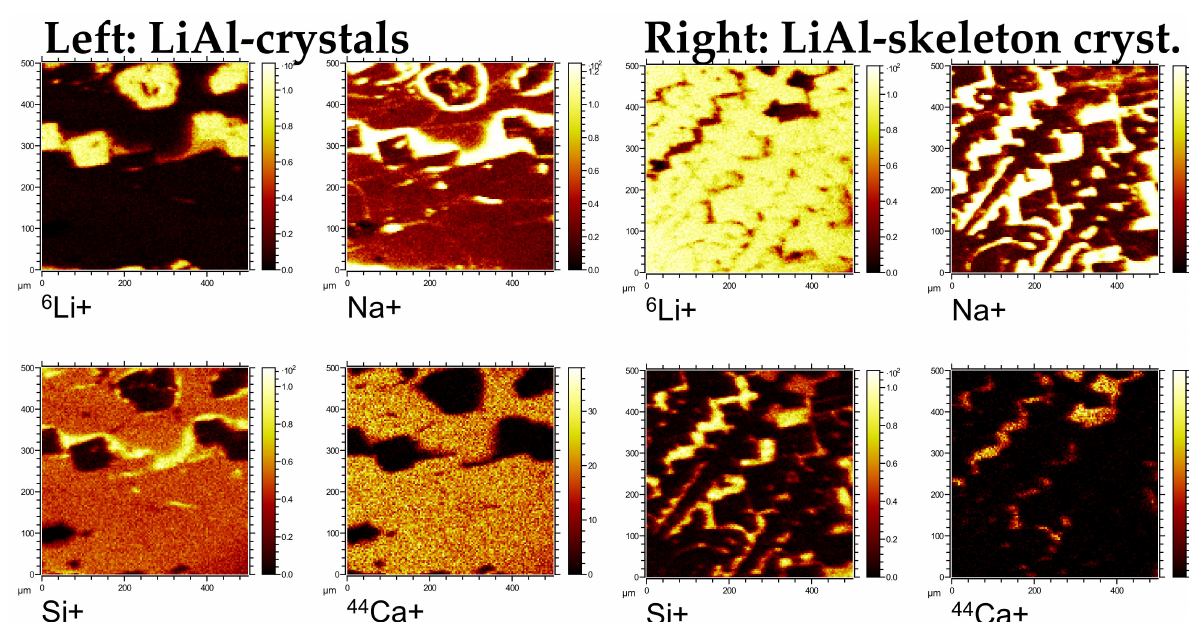
Figure 2. Overview of the lateral intensity distributions of selected positive isotope-resolved secondary ion signals of two different parts of the sample showing LiAl crystals ( left ) and LiAl skeleton crystallizates ( right ) in a Ca-alumosilicate matrix. Due to the signals being too high and the resulting saturation of the detector, the isotopes with smaller natural abundances, 6Li and 44Ca, were chosen for Li and Ca, respectively. Aluminum (Al) has only one isotope, with a mass of 27 amu, and therefore cannot be represented here because of the saturation of the signal.